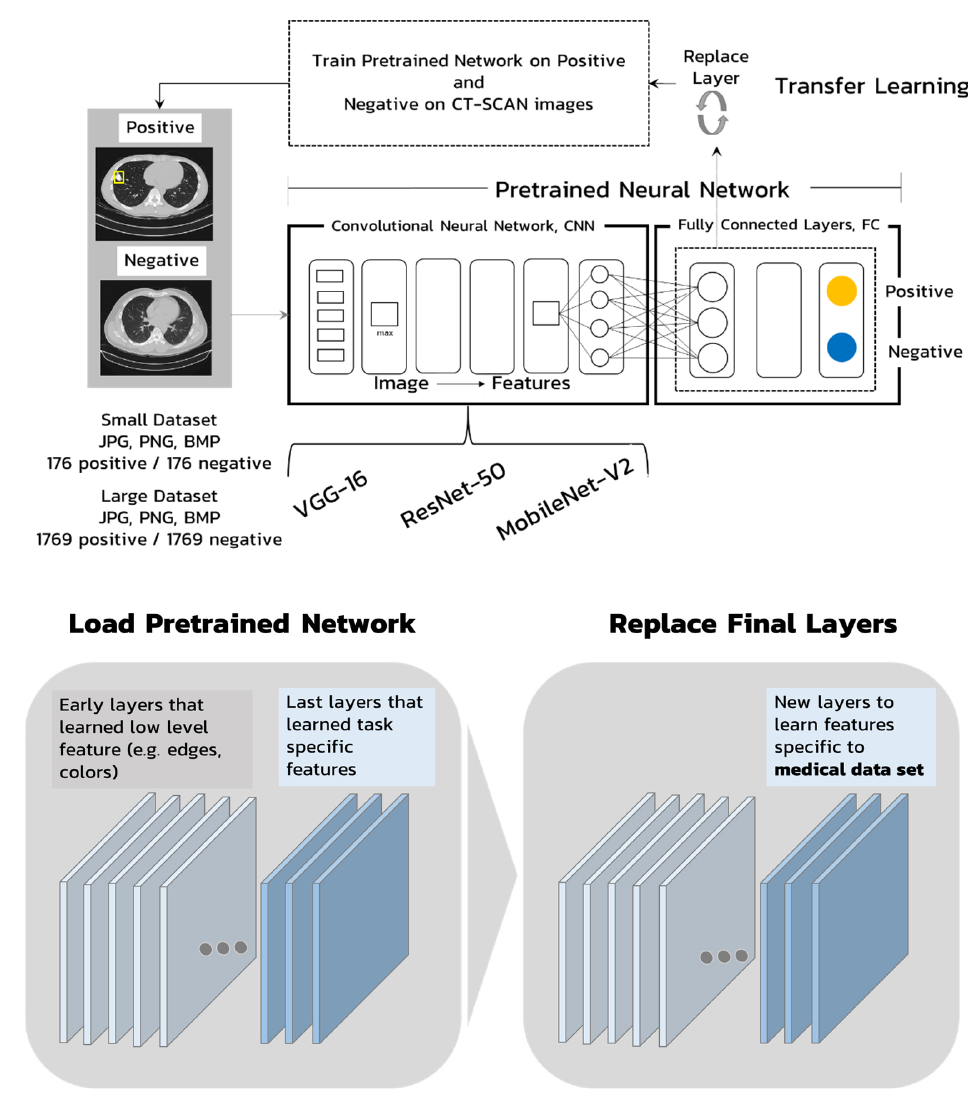
Figure 1. Structure of transfer learning.